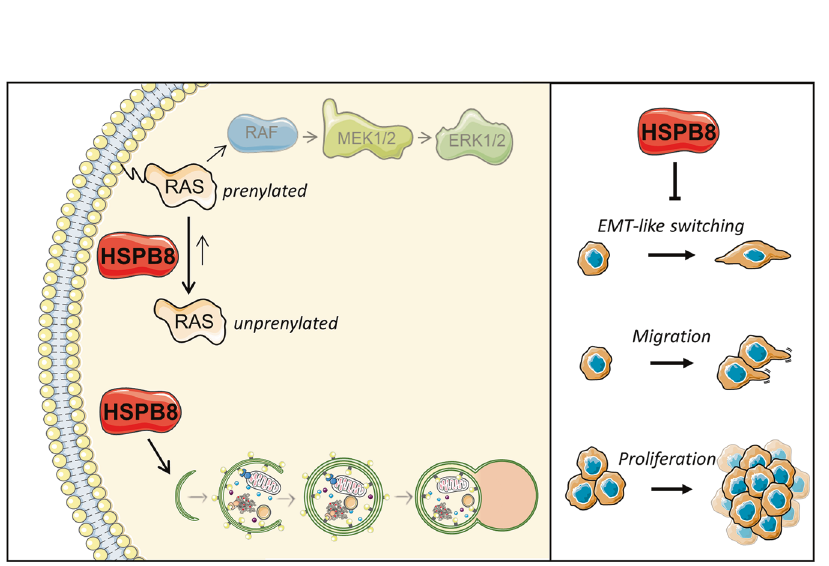
Fig. 8 Mechanisms at the basis of the antitumoral activity of HSPB8 in melanomas cell lines. When expressed in melanoma cell lines, HSPB8 favors the unprenylated form of RAS over the prenylated form, inhibiting the RAF/MEK/ERK pathway, and facilitates autophagy. Therefore, HSPB8 exerts an antitumoral activity by inhibiting (i) the epithelial-mesenchymal transition (EMT)-like switching, (ii) migration, and (iii) proliferation. This fi gure was partly generated using Servier Medical Art templates, provided by Servier, licensed under a